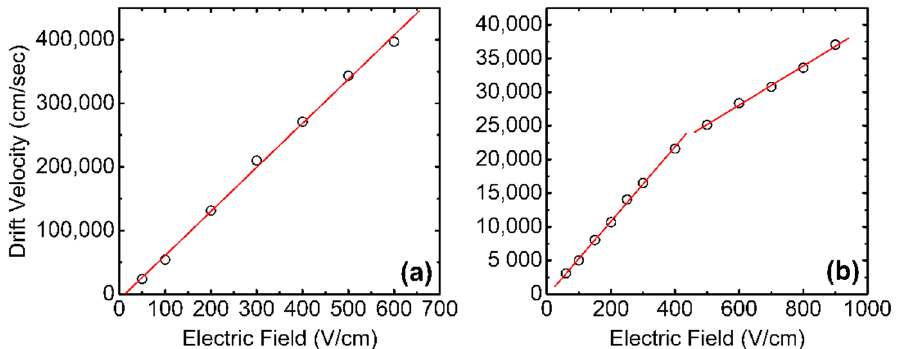
Figure 14. Variation of drift mobilities as a function of electric field measured for electrons ( a ) and holes ( b ) in a VBM grown Cd 0.9 Zn 0.1 Te 0.97 Se 0.03 planar detector (Adapted with permission from ref. [21]. Copyright 2021, AIP Publishing). The solid lines are the straight line fit to obtain the mobilities. Note the two separate slopes in the mobility plot for holes.